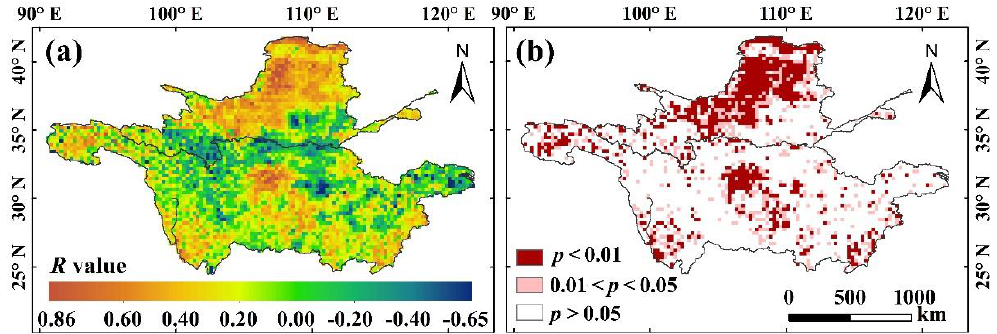
Figure 4. Spatial distribution of the correlation ( a ) and significance ( b ) between NDVI and SEDI.